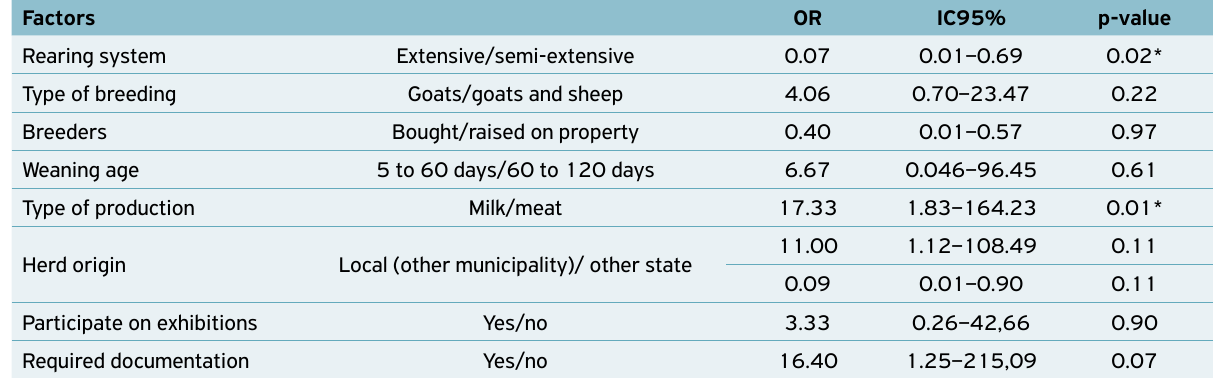
Table 4. Evaluation of the risk factors with the respective odds ratio (OR) and random occurrence probability (p). Factors Rearing